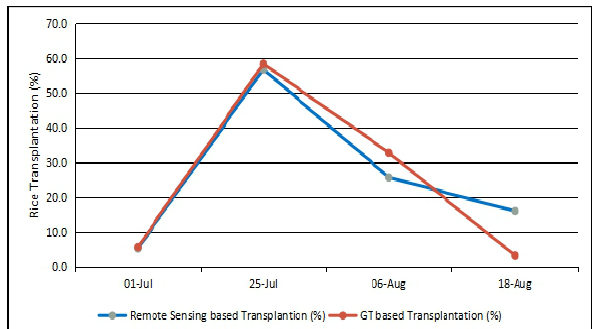
Figure 15: Rice transplantation (%) temporal pattern identified using SAR data and ground truth data in the West Bengal state State Acreage 2014-15 2015-16 2016-17 2017-18